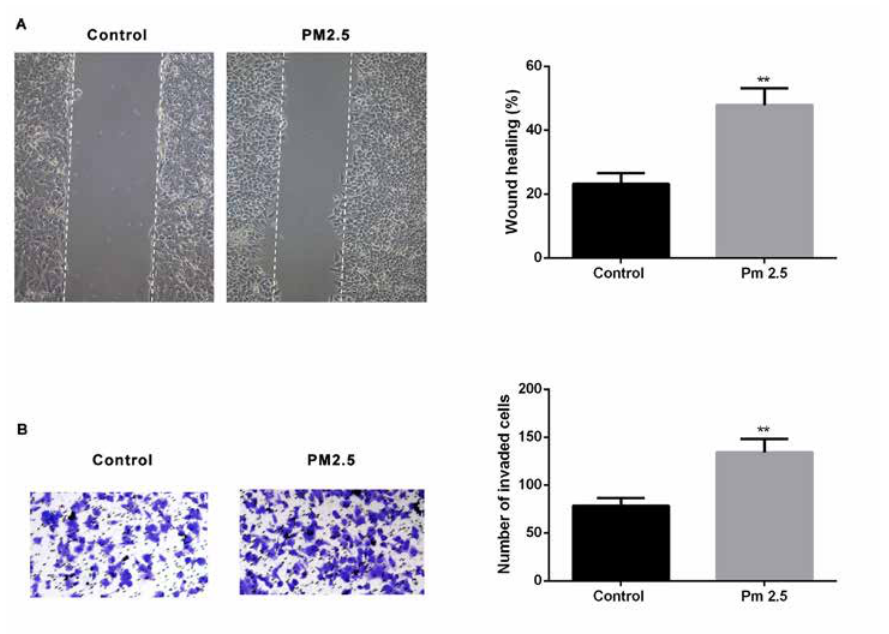
Figure 2: Effect of PM2.5 on metastasis of human SMMC-7721 cells in vitro (A) Scratch wound assay was used to assess the effect of PM2.5 on SMMC-7721 migration at 24 h after PM2.5 treatment. Photographs were taken at 24h after scratch injury under ×200 original magnification. (B) Invasion ability of the cells were examined by transwell assay.